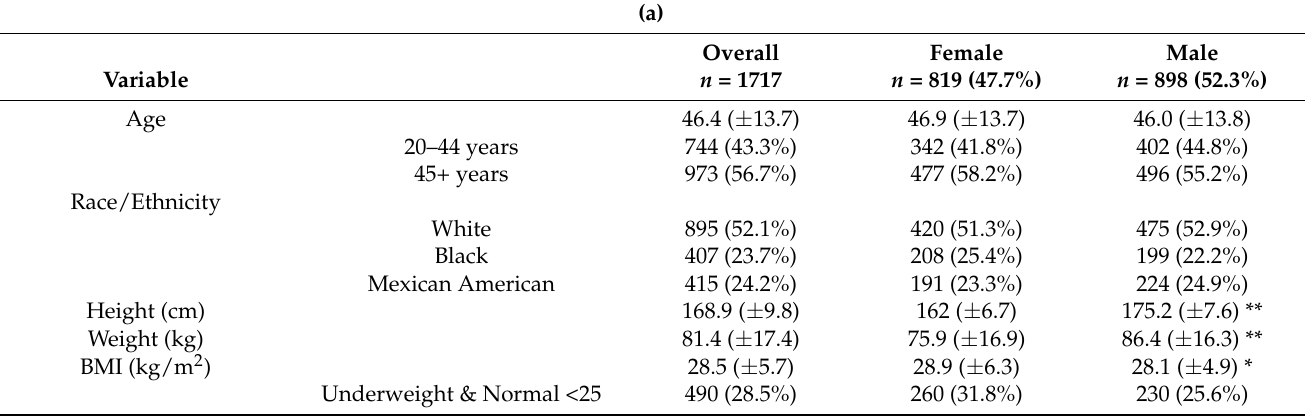
Table 1. (a) Characteristics of participants: overall and by sex. (b) Characteristics of participants by race/ethnicity. (c) Characteristics of participants by age